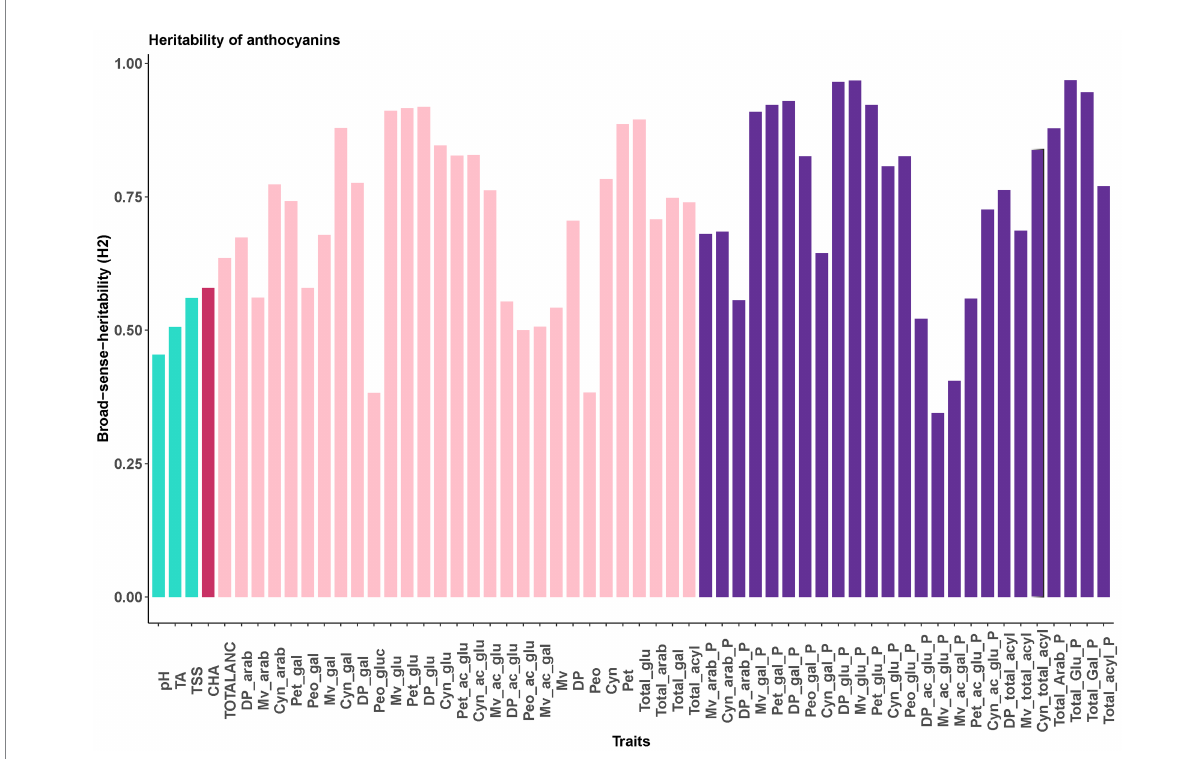
FIGURE 2 Broad sense-heritability for FQ, CHA and anthocyanin related traits. Dp, delphinidin; Cyn, cyanidin; Peo, peonidin; Mv, malvidin; Pet, petunidin; glu, -3-glucoside; gal, -3-galactoside; arab, -3-arabinoside; ac_glu, -3-(6-acetyl glucoside); ac_gal, -3-(6-acetyl galactoside); _P, relative contribution (%). The bar colors represent fruit quality traits (green), chlorogenic acid concentration (red), anthocyanins concentration (pink), anthocyanins composition